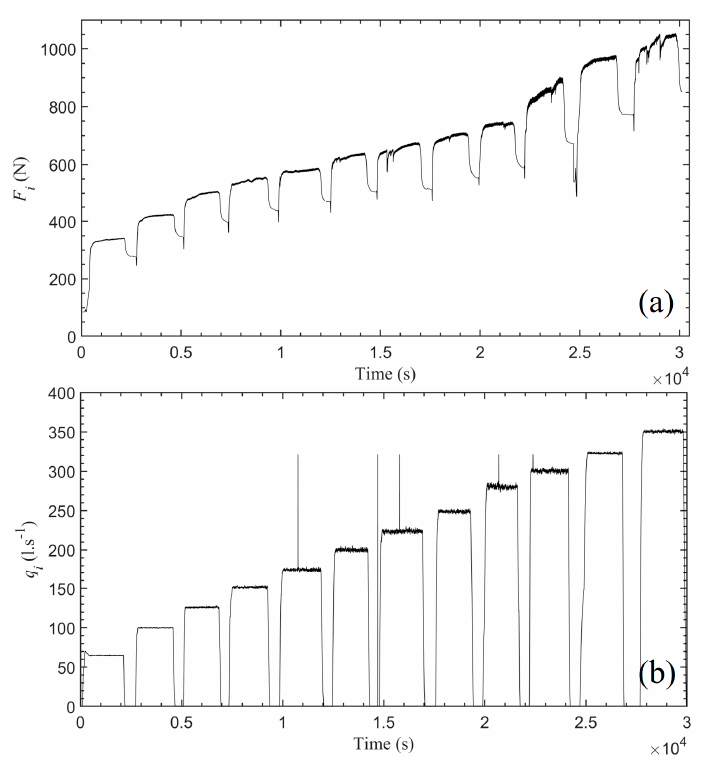
Figure 5. Example of load values ( a ) issued from test D for the six combined cells and associated discharge values ( b ) from the pumps.